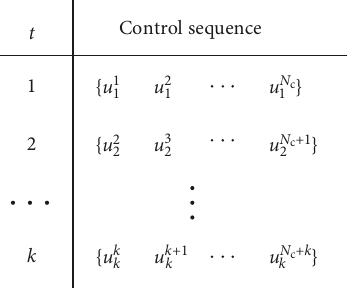
Figure 5: Schematic diagram of control variables selection.